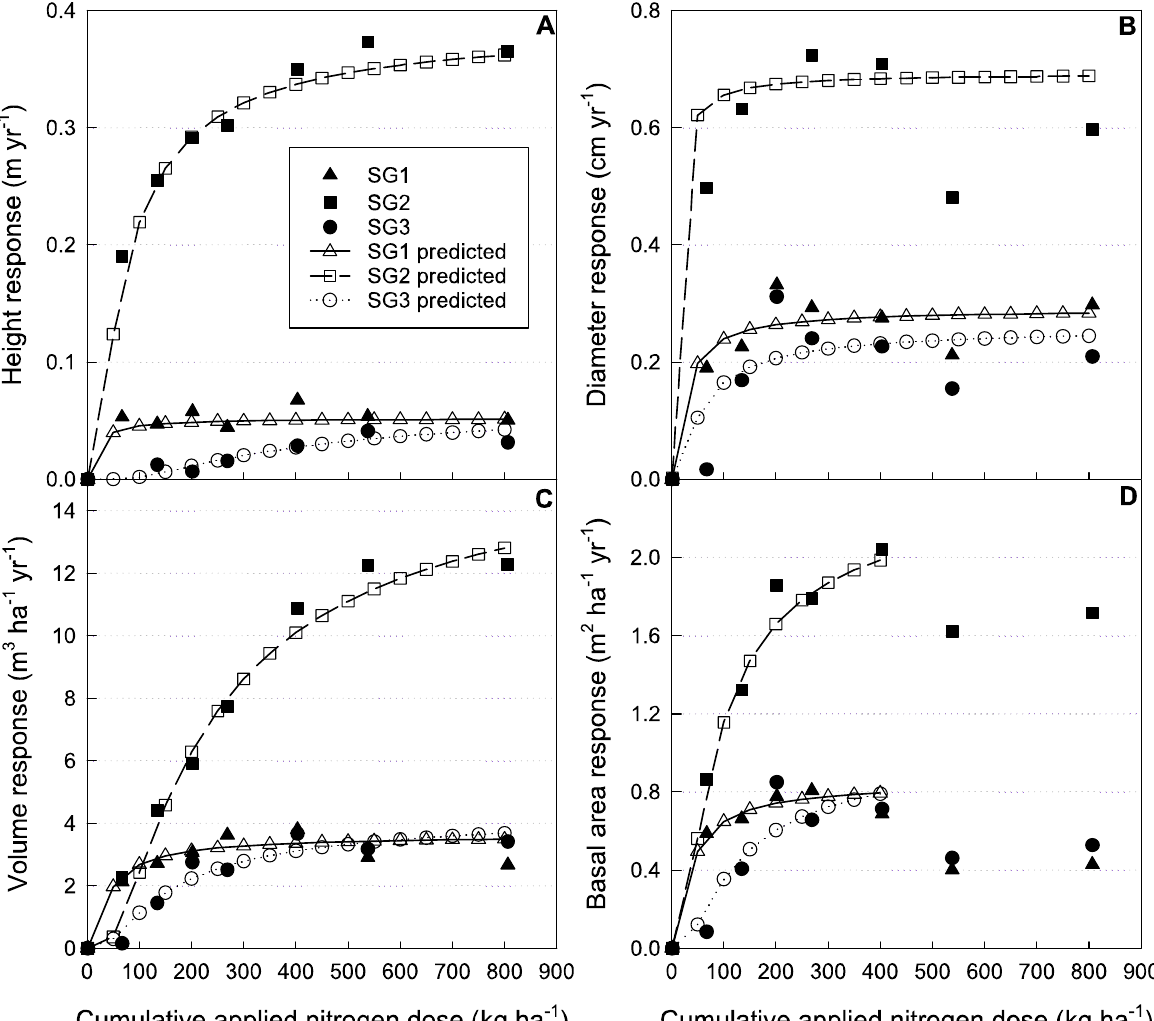
Figure 2. Cumulative applied nitrogen rate response curves for height, diameter, volume and basal area (Panels A, B, C, and D, respectively) for three soil groups (SG1, SG2 and SG3) where nitrogen was applied at different rates and frequencies across 22 sites in the southeastern United